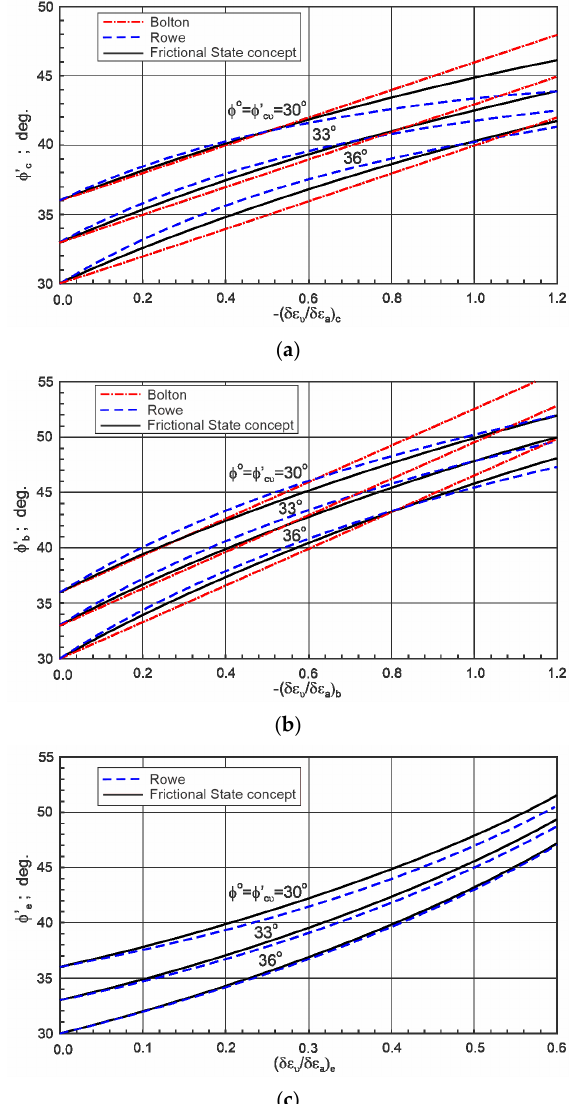
Figure 1. Relationship between the friction angle and strain increment ratio: ( a ) Triaxial compressing testing, ( b ) Biaxial testing, ( c ) Triaxial extension testing.